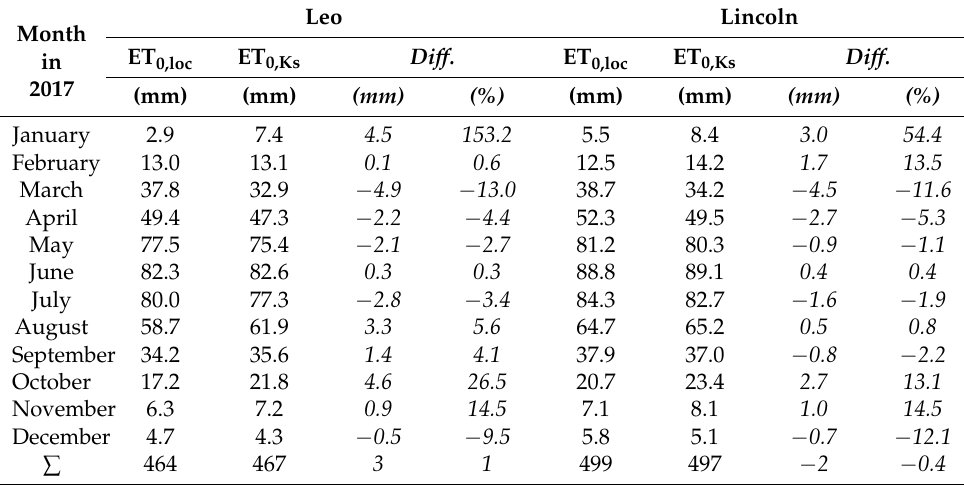
Table 6. Comparison of ET 0 out of local measurements ( ET 0, loc ) with the K S -modified ET 0 of the reference station ( ET 0, Ks ) for